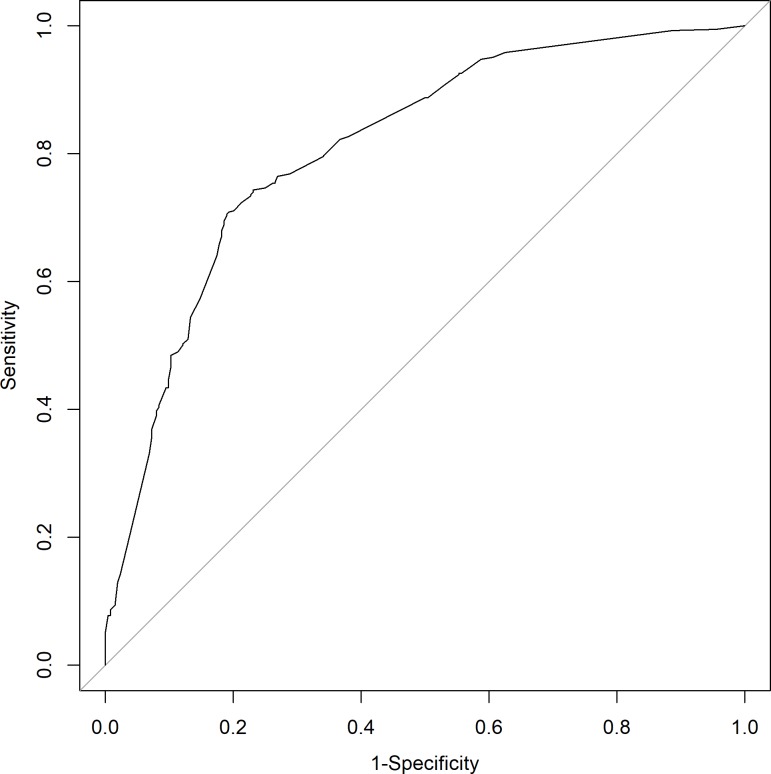
Receiver operator characteristic curve of the final multivariate model.